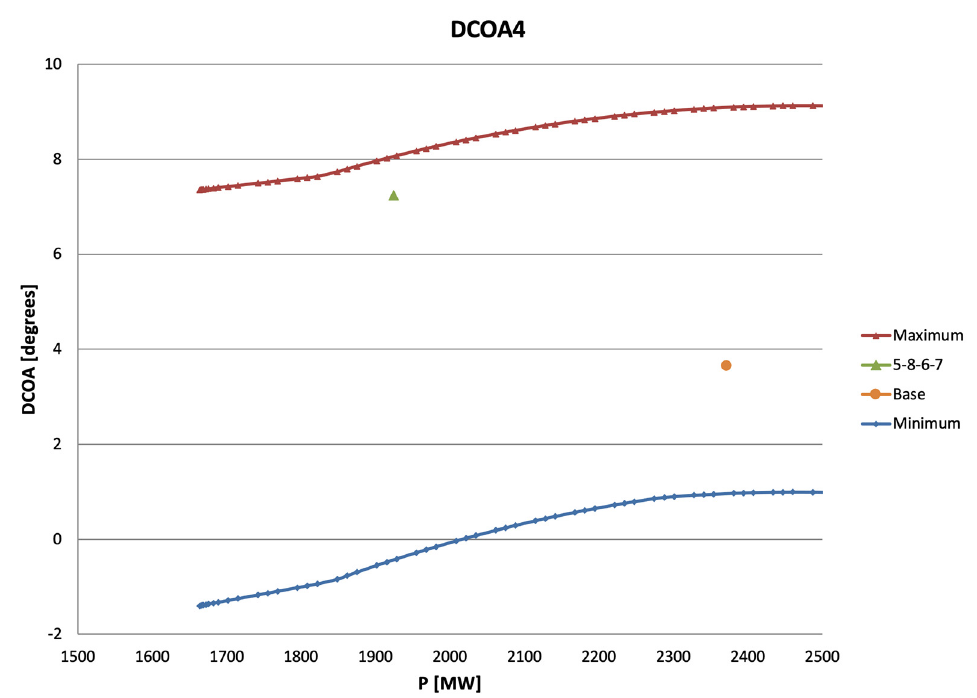
Figure 18. Angular thresholds characterization for contingencies N-1 in operational area 4 (outages of lines 5–8 and 6–7).